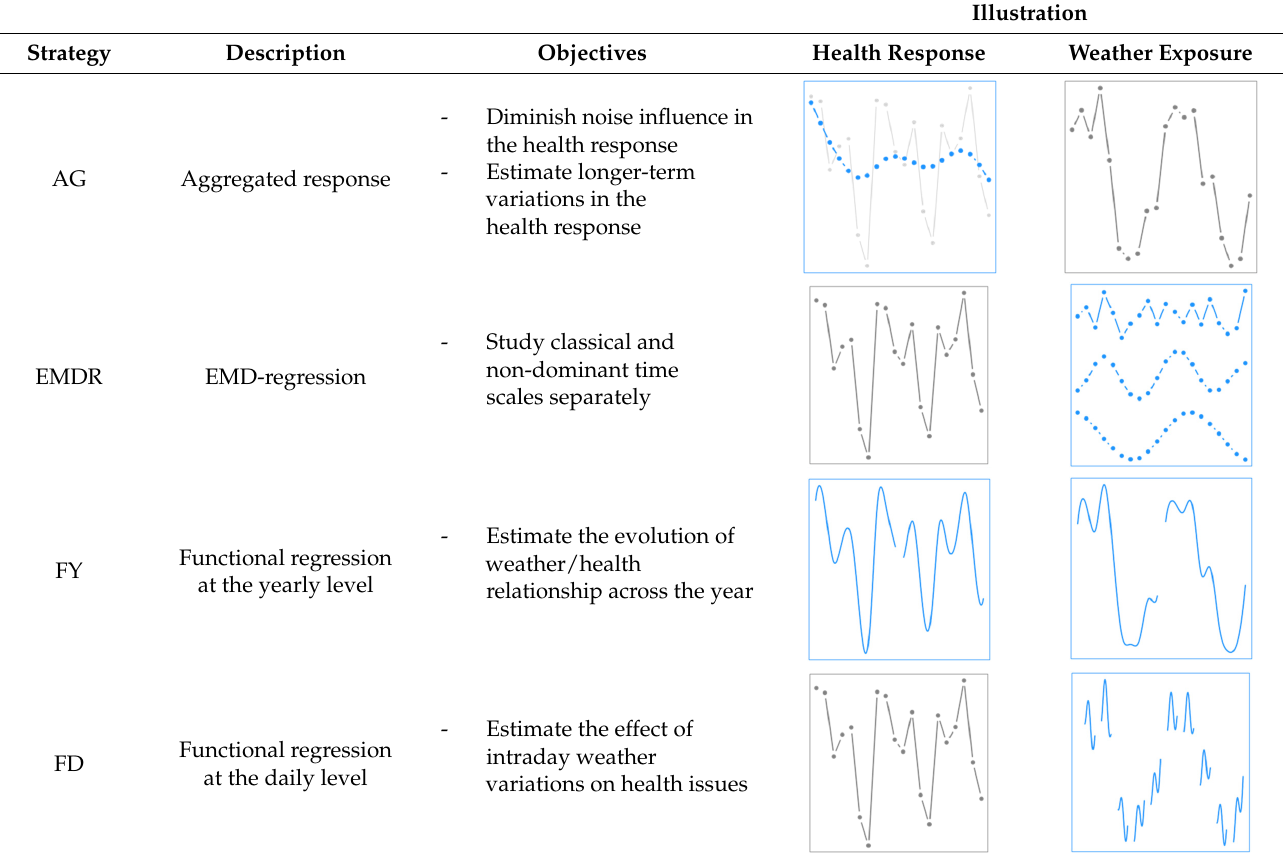
Table 1. Summary of each strategy including its objectives and illustrations. In each strategy, prior modifications of data are shown in blue, and data used directly are shown in grey.